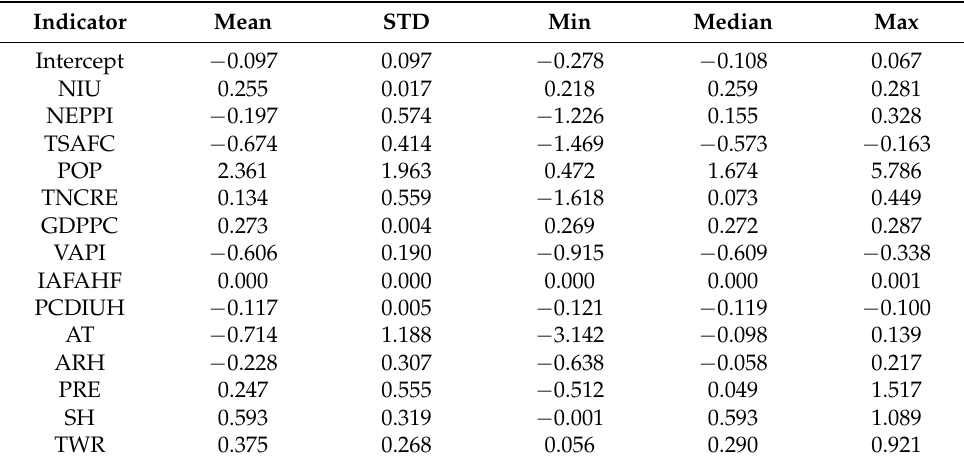
Table 15. Summary statistics of MGWR parameter